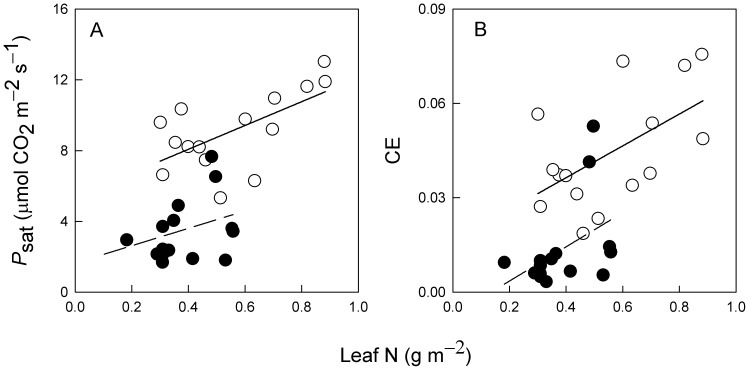
The relationships between leaf nitrogen concentrations (Leaf N) and P
sat (A) and CE (B) for M. micrantha plants either uninfected (○; solid line) or infected (•; broken line) with C. campestris (Data from all nitrate treatments are included).The correlation coefficients are 0.62 (P<0.05) and 0.40 (P>0.05) in (a), and 0.56 (P<0.05) and 0.44 (P>0.05) in (b) for the uninfected and infected plants, respectively.